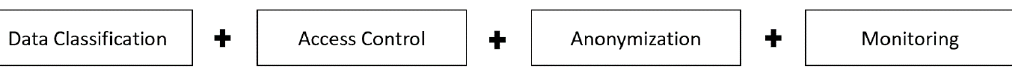
Figure 5. Security broker components of MOBDA.